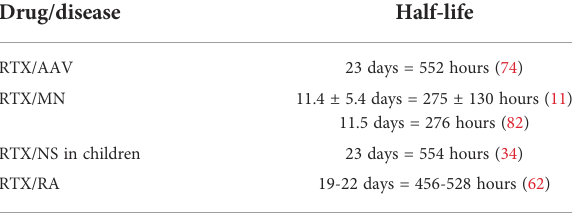
TABLE 2 The half-lives of RTX in various autoimmune diseases.